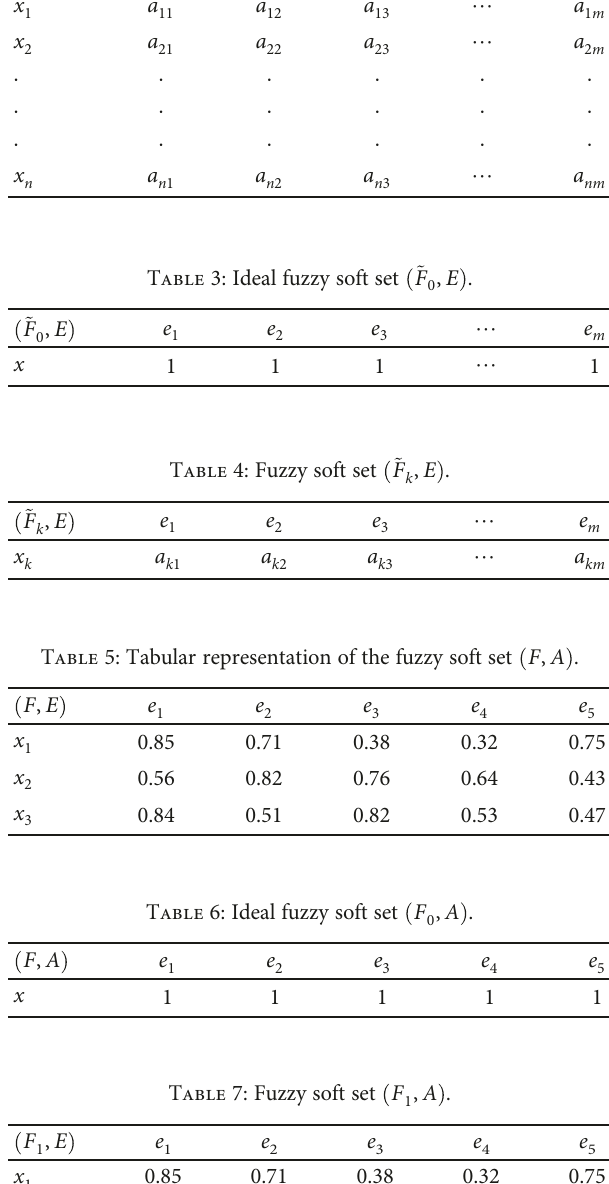
Table 8: Fuzzy soft set F